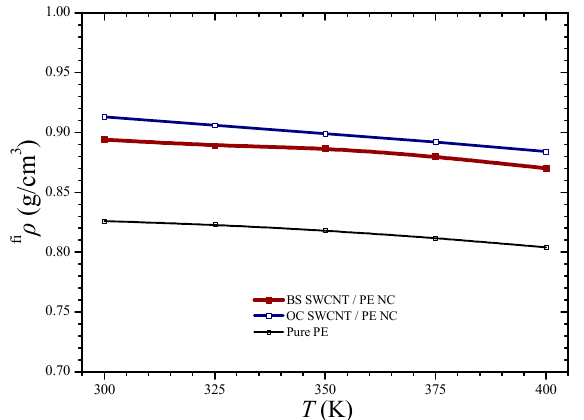
Figure 6. The final density of the simulated materials versus the temperature.